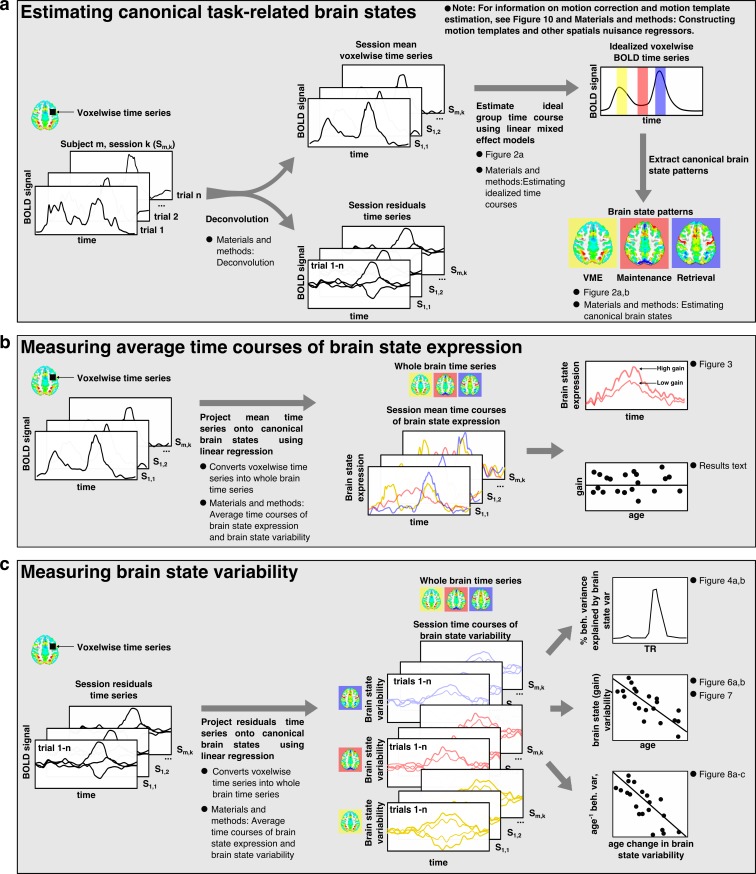
Brain state analysis flowchart.A flowchart outlining the major steps involved in the brain state analyses. Where appropriate, the descriptions include a cross-reference to relevant figures depicting major analyses based on the output of each process as well as a cross-reference to the relevant section of Materials and methods for further detailed information on how the process or analysis was implemented.